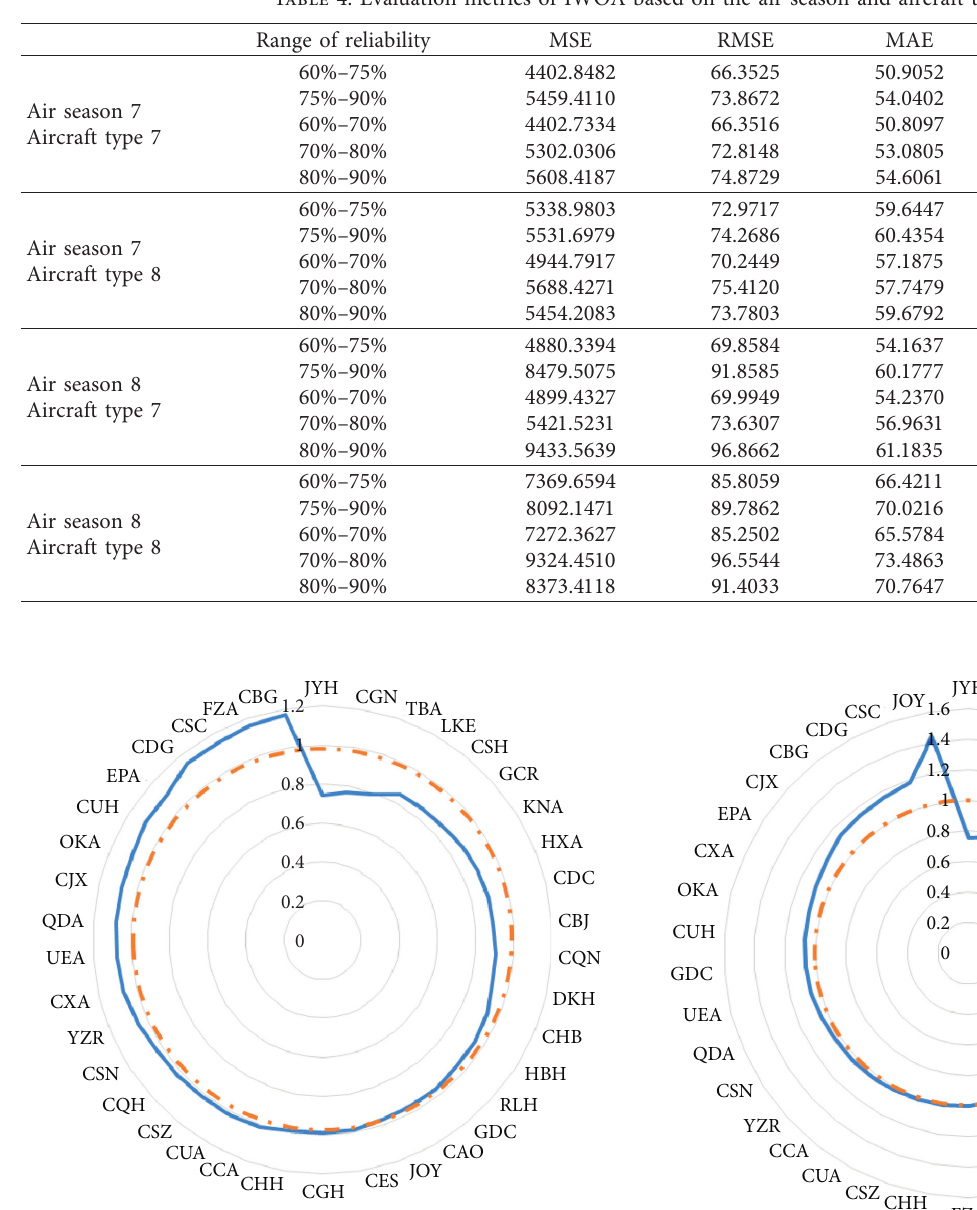
Table 4: Evaluation metrics of IWOA based on the air season and aircraft type.